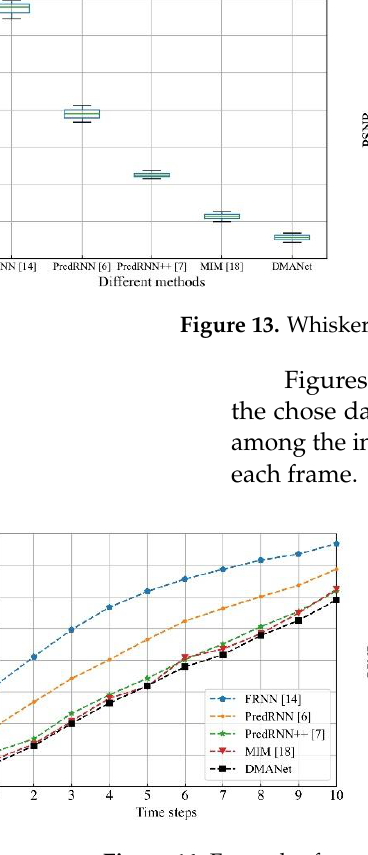
Figure 14. Frame-by-frame quantitative results for the 10 frames at the Moving MNIST [34].